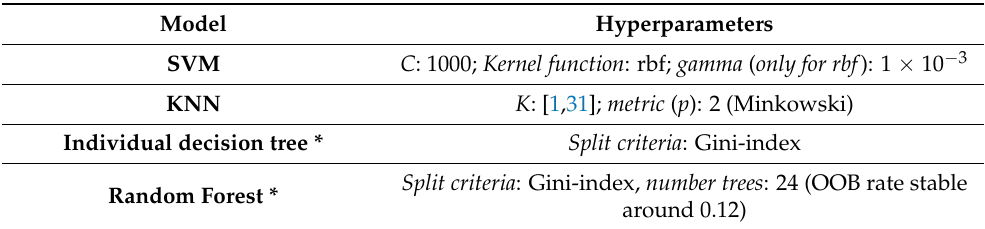
Figure 17. Random Forest feature importance using MDA criterion. Table 8. Optimized